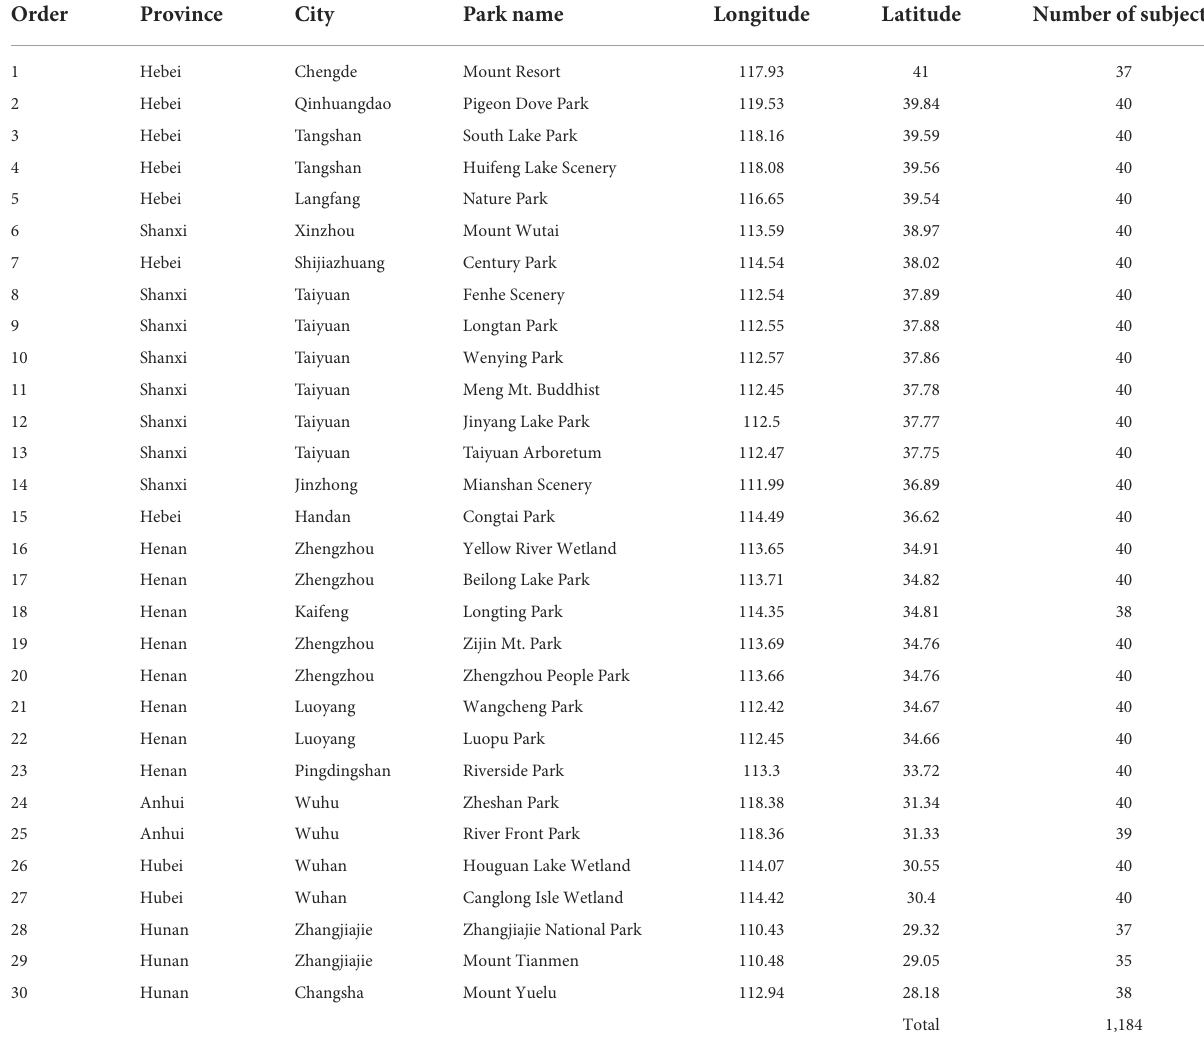
TABLE 2 Parks in urban wetlands with the respective number of samples in cities of China.